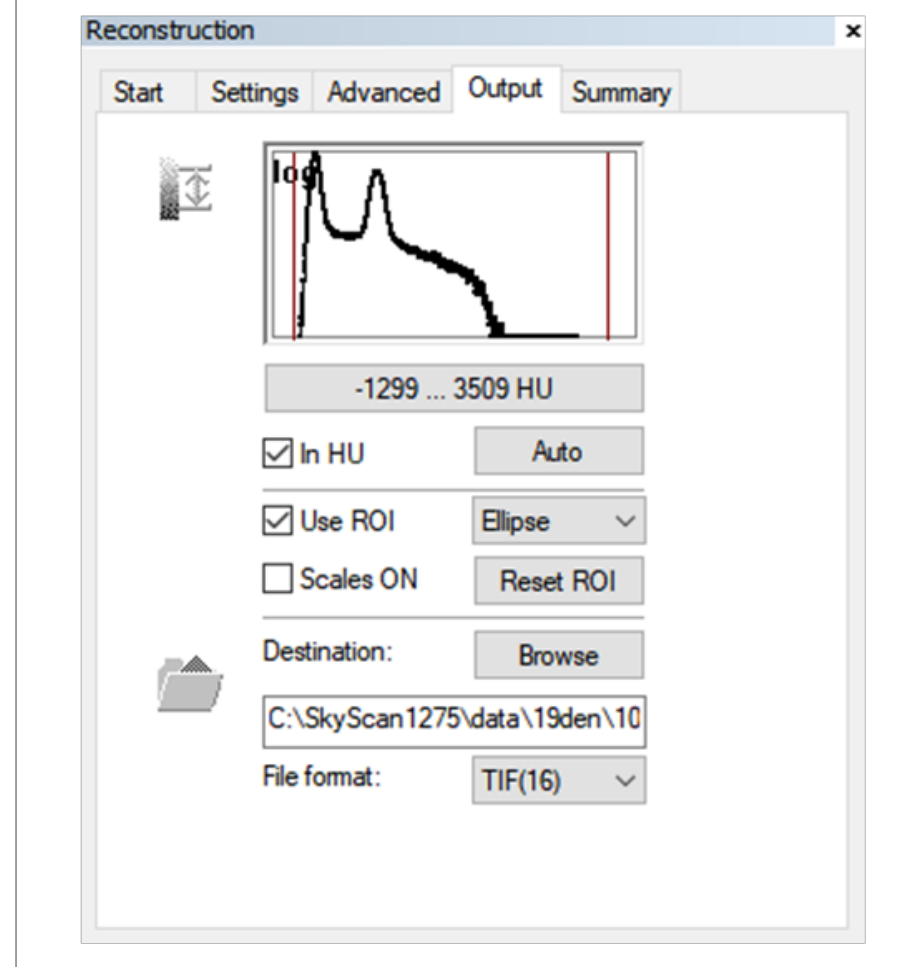
Figure 8. Nrecon SW MENU detail — reconstruction of outputs (parameter settings).